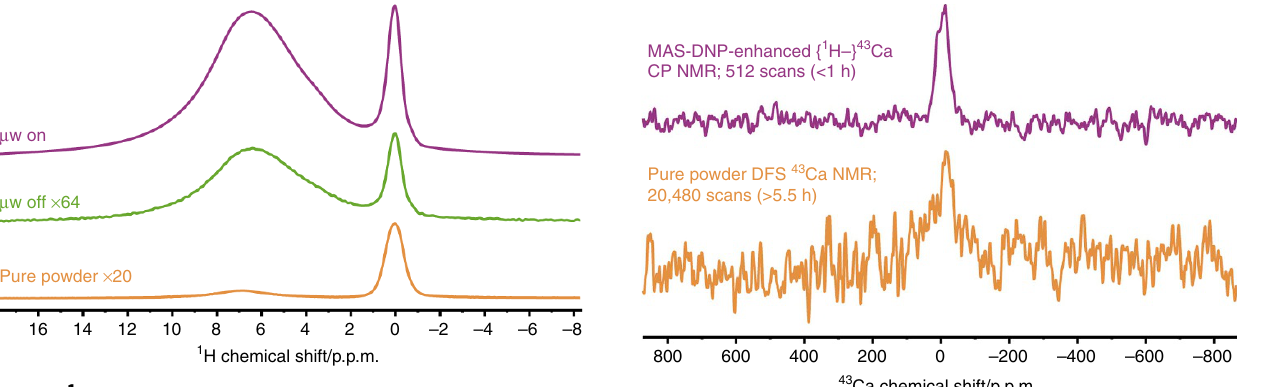
Figure 2 | 1 H Hahn-echo MAS NMR spectra of C–HAp. All were recorded at B 100K and 9.4T. The pure powder (orange, MAS rate ¼ 8.5kHz) and the DNP-ready sample with (purple) and without (green) microwave irradiation suitable for DNP (both recorded using a MAS rate of B 14kHz) are shown and scaled according to the factors given.